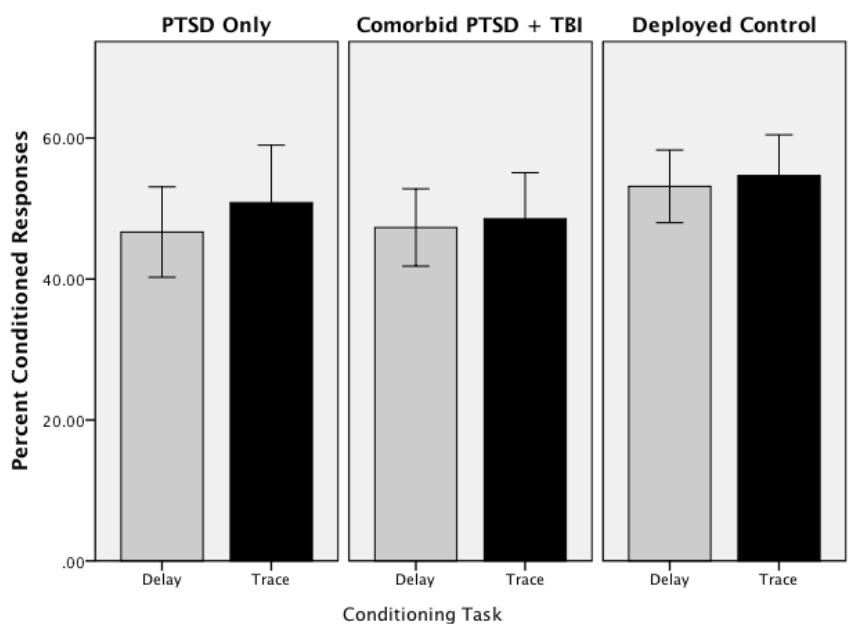
Figure 2. Mean percent conditioned responses for delay and trace eyeblink conditioning (error bars: +/ − 2 SE).